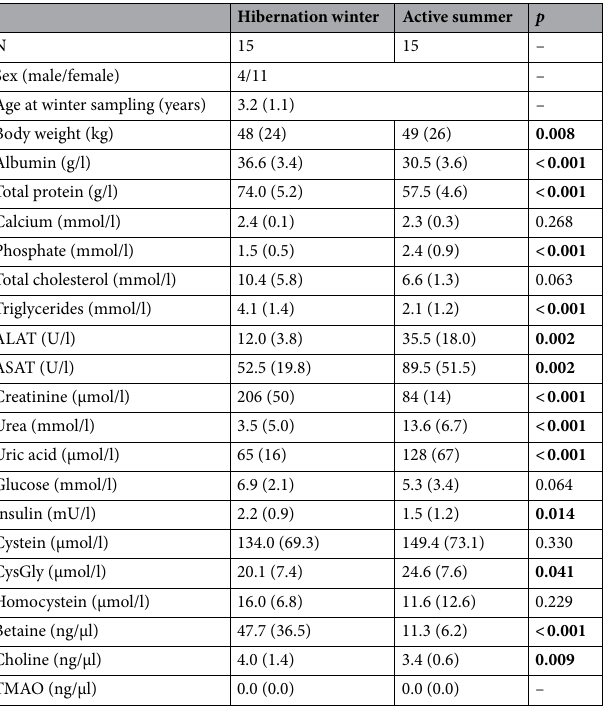
Table 1. Characteristics of free-ranging brown bears during hibernation and the summer active state. Characteristics of the free-ranging brown bears during hibernation and the active state, divided into winter (i.e. hibernation) and summer (i.e. active) blood samplings. ALAT, Alanine transaminase; ASAT, Aspartate transaminase; TMAO, Trimethylamine N-oxide. Values for median (interquartile range) or total number are shown. p values as assessed by non-parametric Wilcoxon signed-rank test.